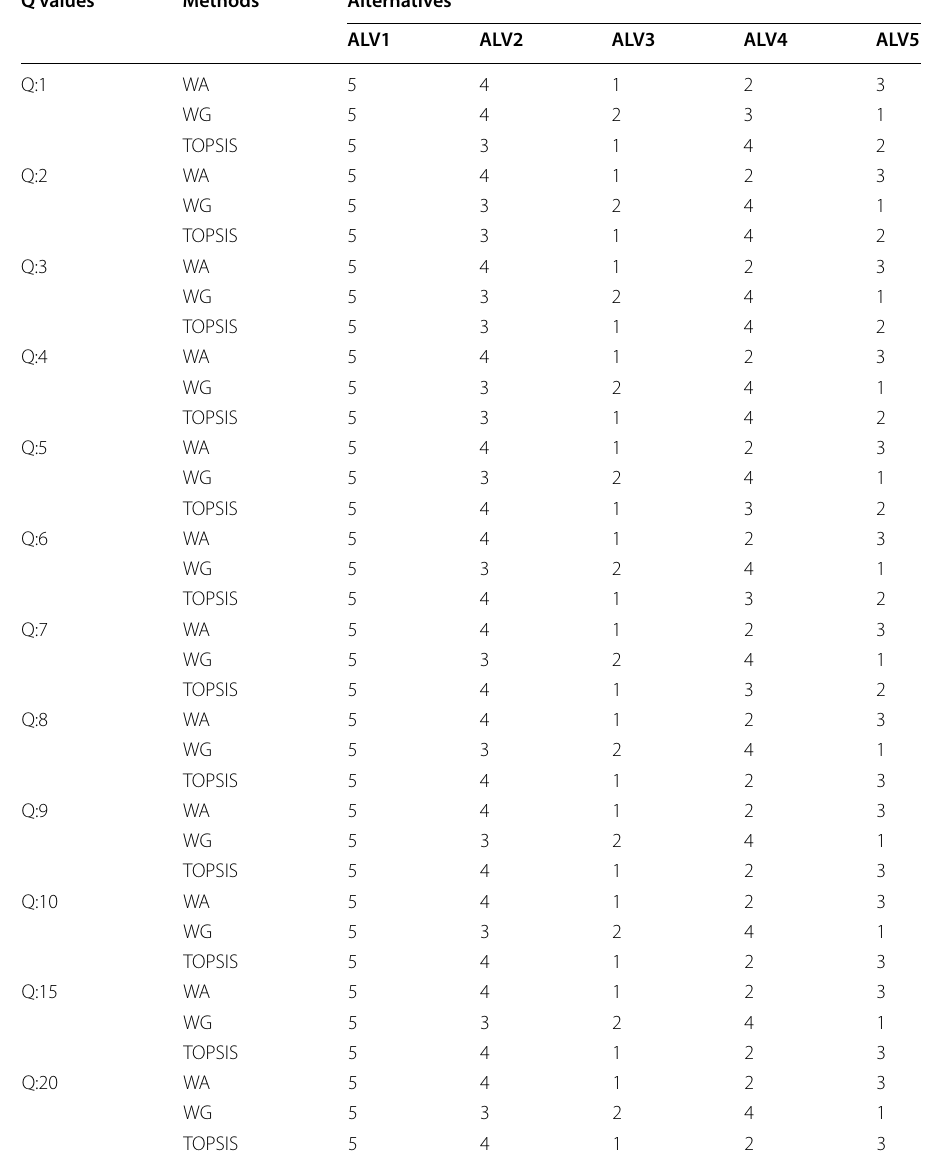
Table 14 Ranking alternatives with different q-values Q